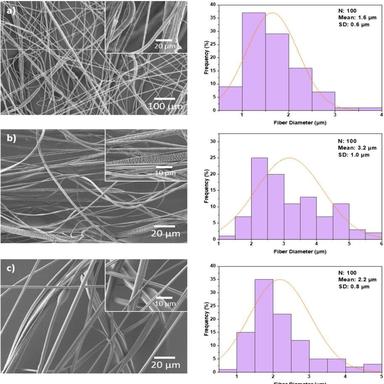
SEM micrographs of IBP loaded fiber composites: a) 15 w/v % PEO 4 wt % IBP, b) 15 w/v % PCL 4 wt % IBP, and c) 4:1 PCL:PEO 4 wt % IBP, all spun at 10 000 rpm and 0.1 MPa applied pressure.